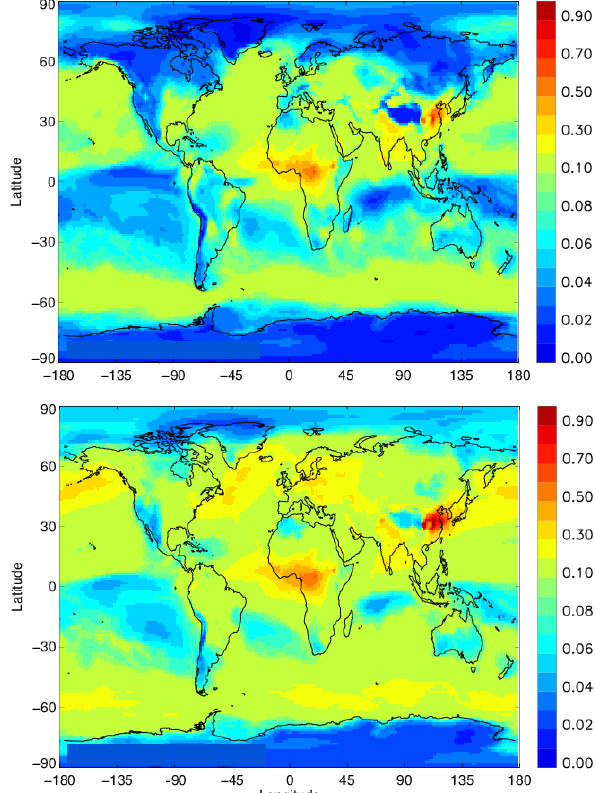
Figure 1. E-suite verification example. Total AOD plots showed that there was a considerable loss of aerosol of 30%, from a mean AOD of 0.14 to 0.094, after a 96h forecast in the e-suite (top panel) compared to the o-suite (bottom panel). The Ångström exponent showed considerably smaller particles in the e-suite as compared to the o-suite. Because of this the o-suite upgrade of April 2013 was postponed. The problem was solved and a new e-suite run was tested positively in August 2013. Example taken from the e-suite report of April 2013 (Eskes et al.,